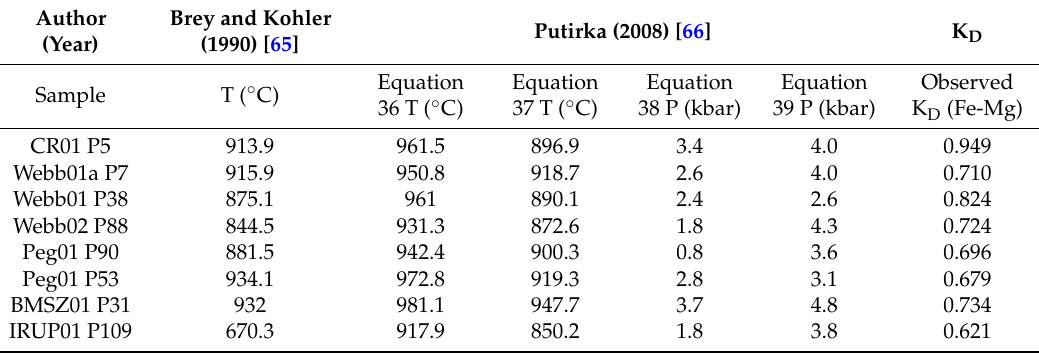
Table 8. Calculated two pyroxene temperatures and pressures for Unki Mine MSZ